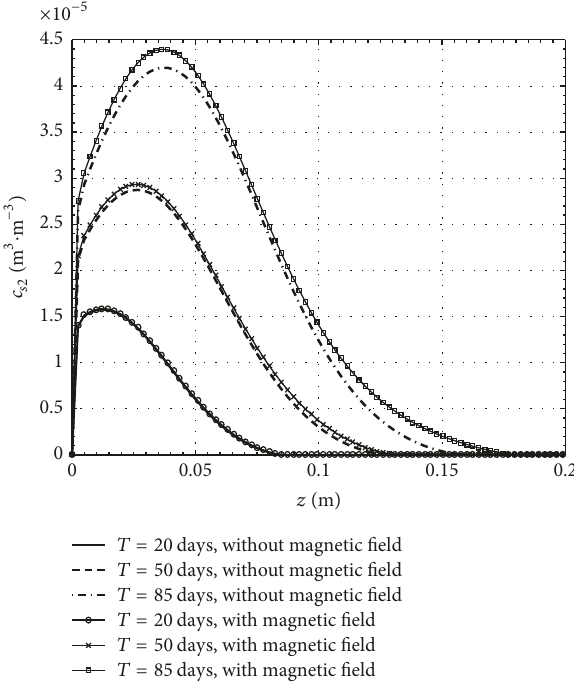
Figure 7: Pore throat deposited nanoparticles concentration against core length with and without magnetic field effect for various values of imbibition time: magnet is placed on the right side of the